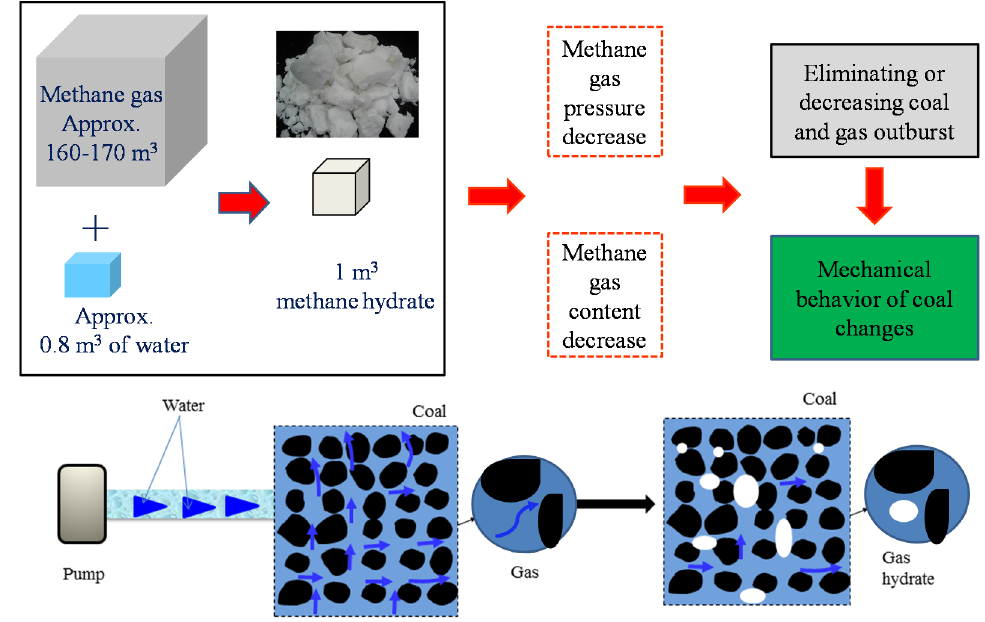
Figure 2. Schematic diagram for the hydrate ‐ based method for preventing coal and gas outbursts [11].